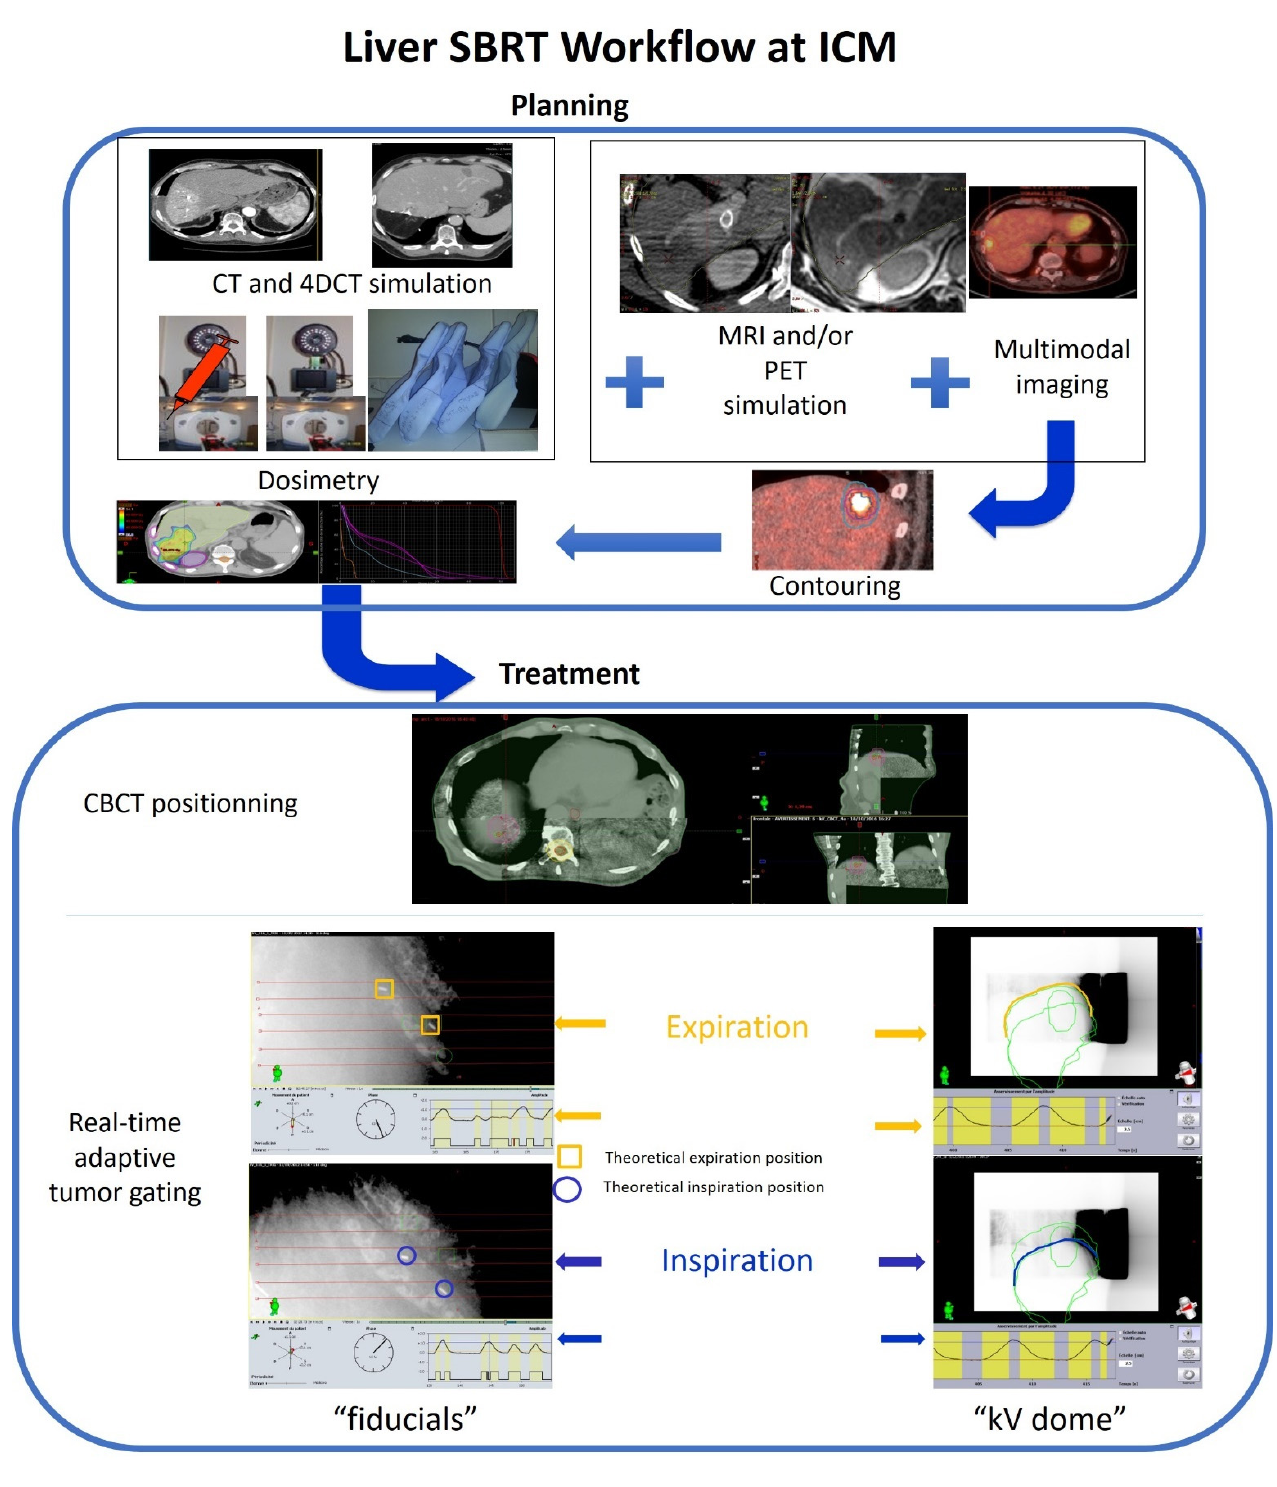
Figure 1. Liver SBRT workflow at ICM.